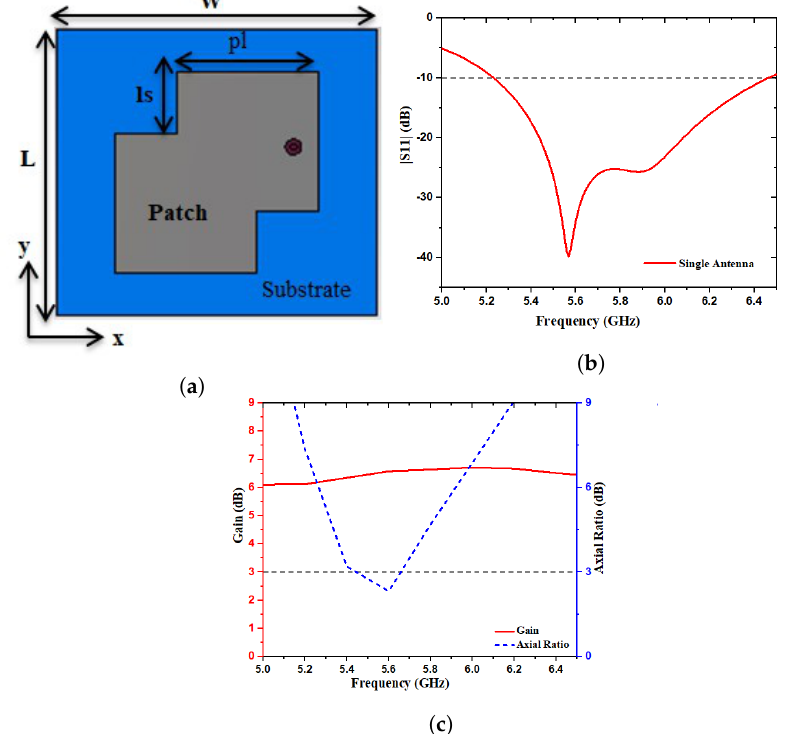
Figure 1. ( a ) Single antenna geometry. ( b ) Simulated S11. ( c ) AR and